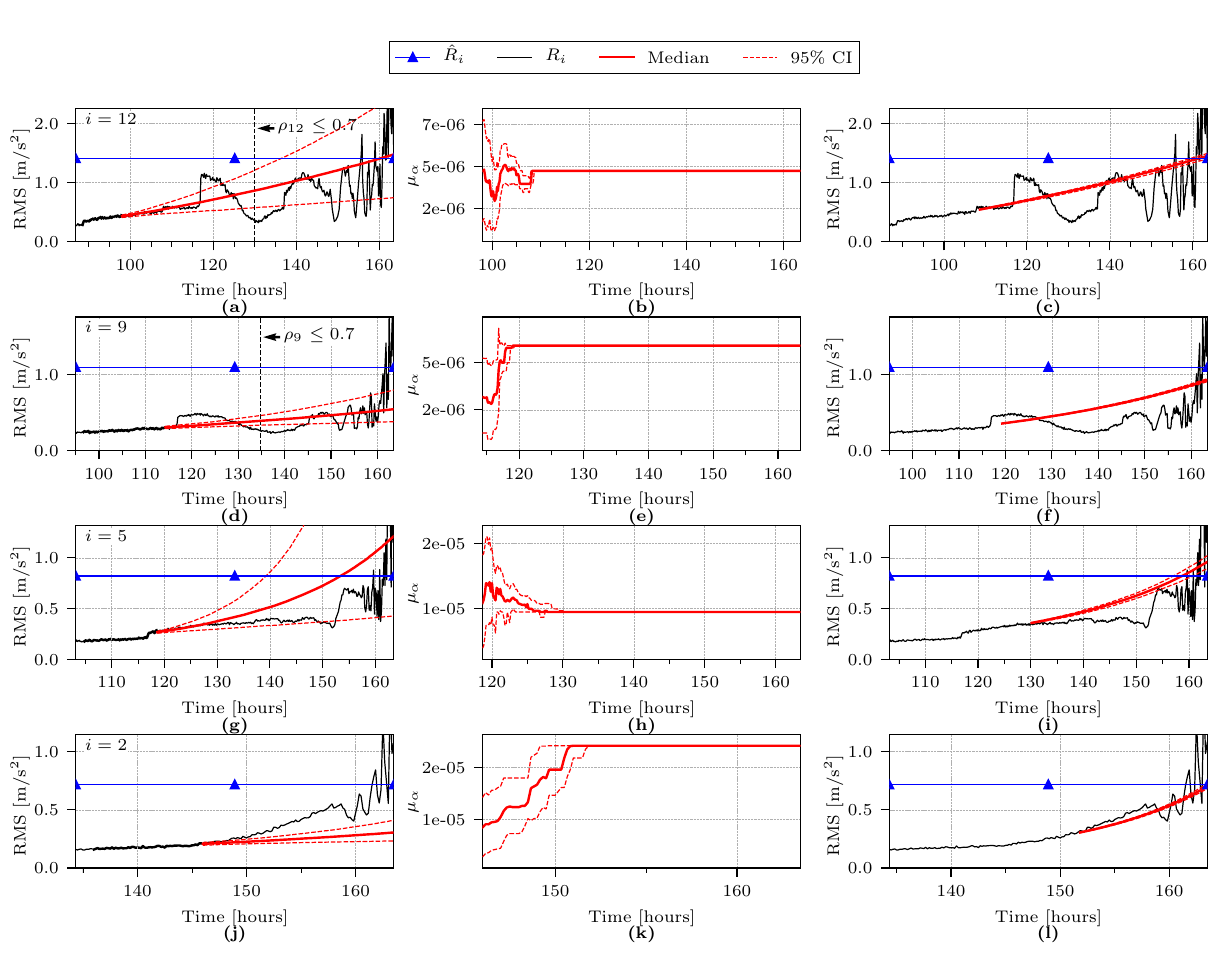
Figure 4: Identified RMS trends, and output of the corresponding PFs. Rows 1-4 indicate i = [12 , 9 , 5 , 2]. (column 1) R , FT ˆ R , and median and 95% CI of initial PF output; (column 2) µ i i initiated PF; (column 3) predicted PF trend when µ